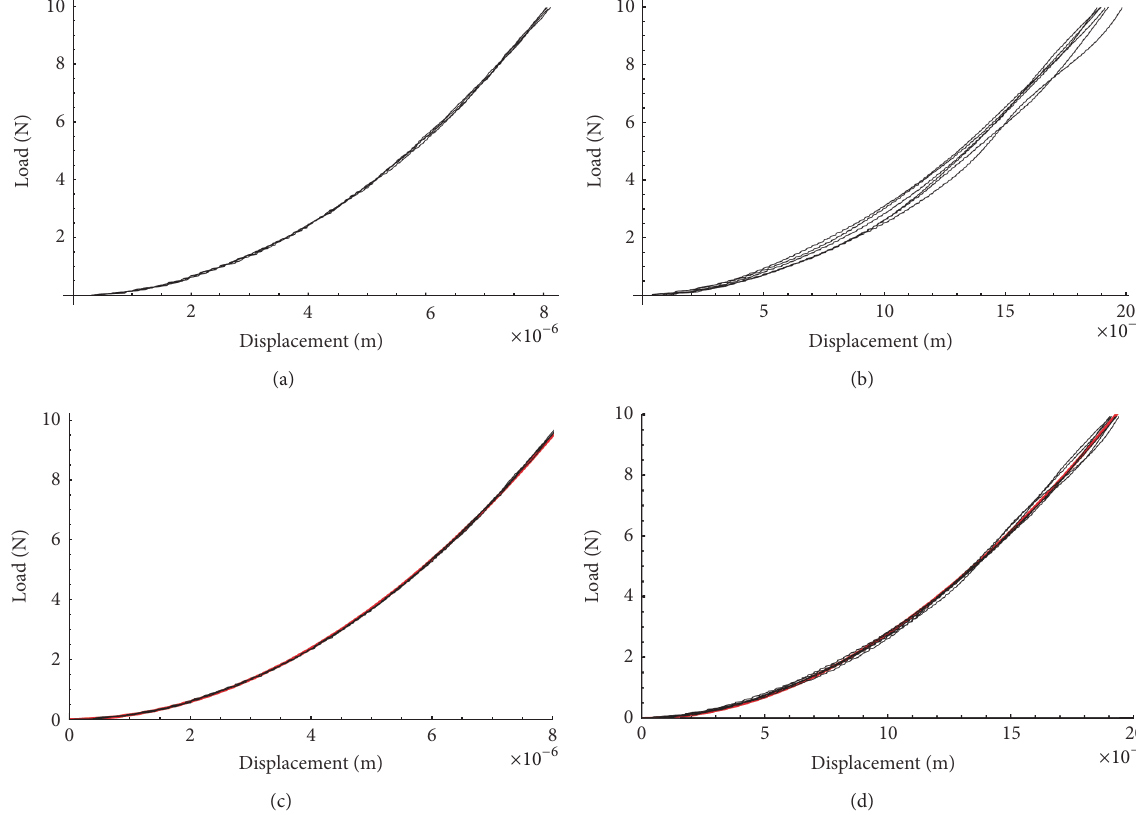
Figure 1: Original data for steel (a) and brass (b) as compared to corrected data ((c) steel, (d) brass), with the fitting curve plotted in red. The measured data for the steel calibration block (4 curves) show a remarkably low dispersion and so the effect of the data correction appears to be small. For the brass calibration block (6 curves), the benefits of the procedure are easily observable (quantitative details are given in Table 1).